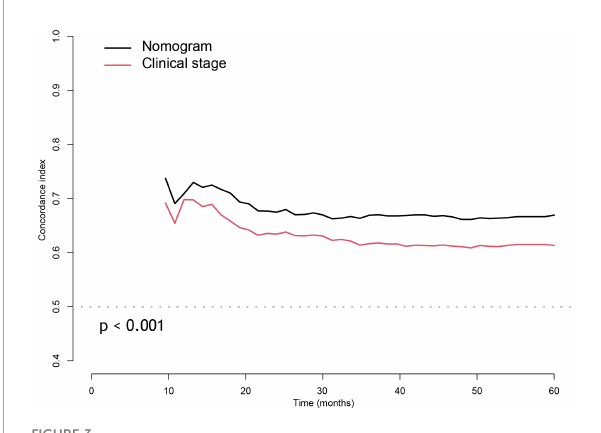
FIGURE 3 The Concordance index of nomogram compared with the clinical stage with cross-validation in external validation cohort.